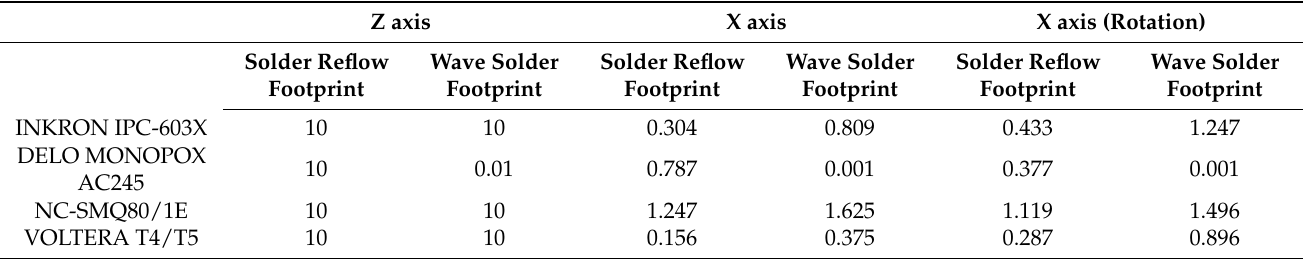
Table 7. Maximum force (N) applied on the